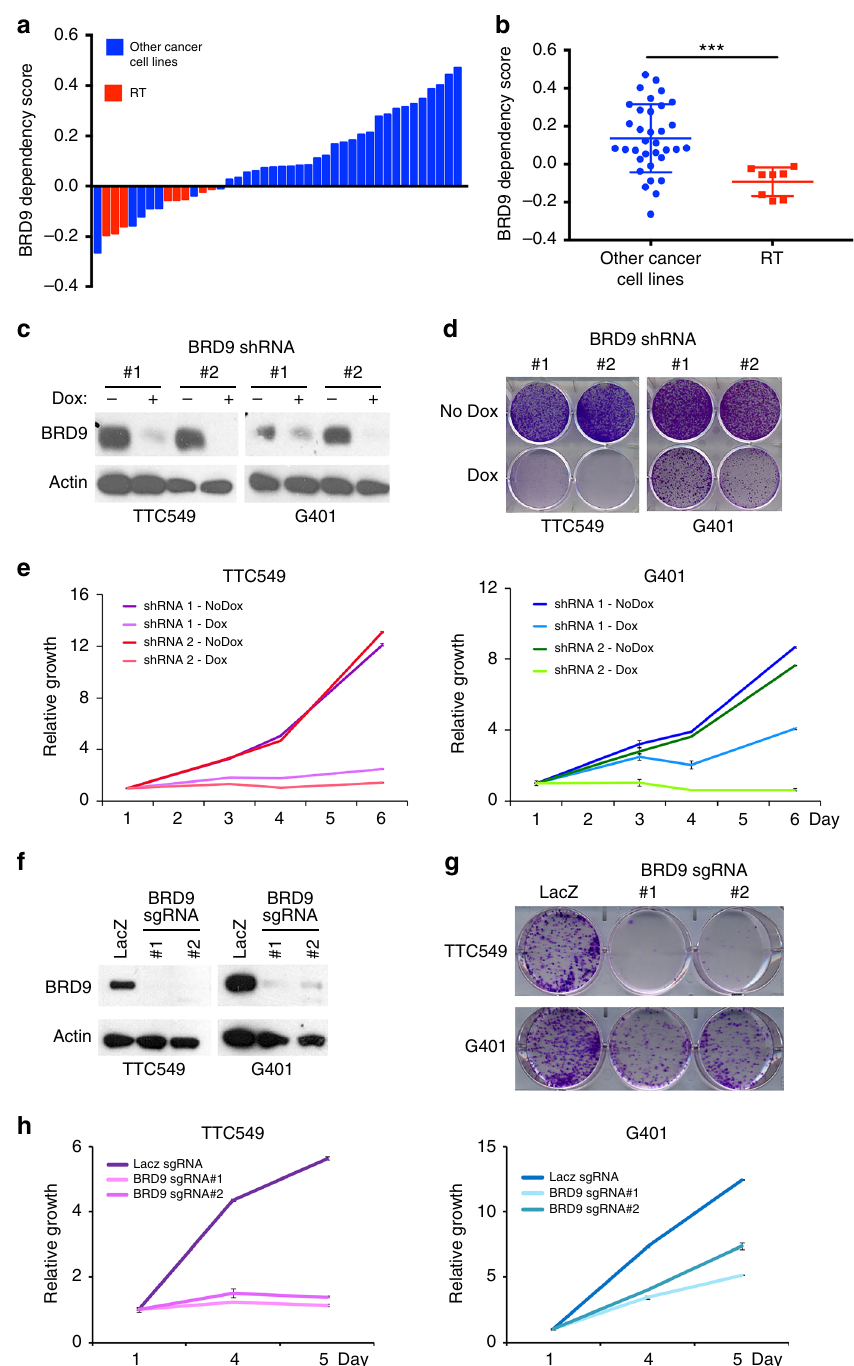
Fig. 1 Genome-wide CRISPR-Cas9 screen identi fi ed BRD9 as a RT speci fi c dependency. a , b SMARCB1 -mutant RT cell lines are more sensitive to BRD9 loss in the CRISPR-Cas9 screen. Red: Rhabdoid Tumor cell lines; Blue: all other cancer cell lines. c Western blot showing BRD9 knockdown via shRNA in G401 and TTC549 RT cell lines. d , e shRNA-mediated BRD9 knockdown impairs cell proliferation: colony forming assay ( d ) and MTT assay ( n = 3, error bars: SD) ( e ). f Western blot showing BRD9 deletion via CRISPR-Cas9 in G401 and TTC549 cell lines. g , h BRD9 deletion via CRISPR-Cas9 impairs cell proliferation: colony forming assay ( g ) and MTT assay ( n = 3) ( h